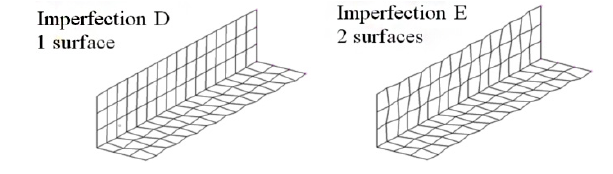
Figure 6. FE models of additional sets of imperfections D and E